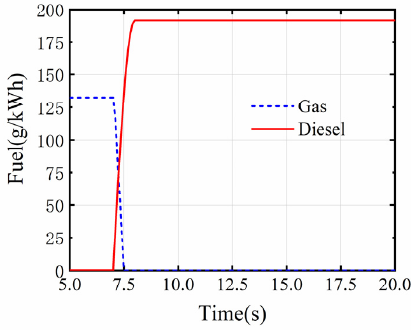
Figure 6. Fuel change curve.